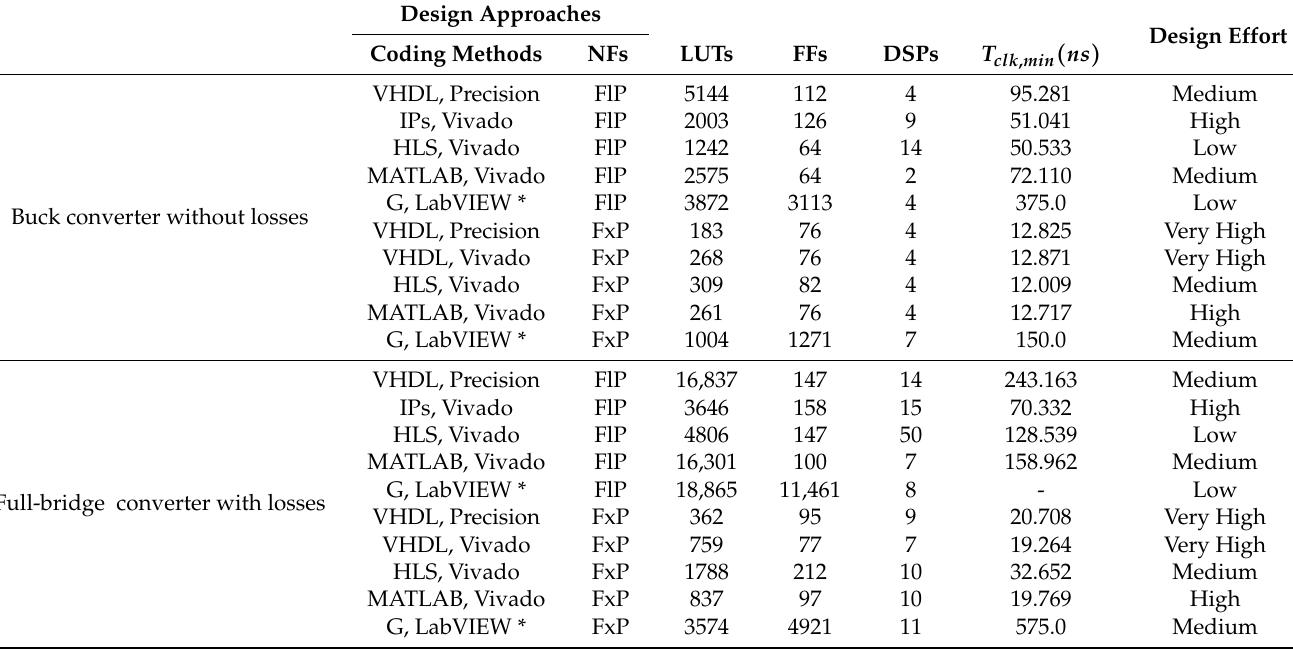
Table 7. The comparison of different possible design alternatives.